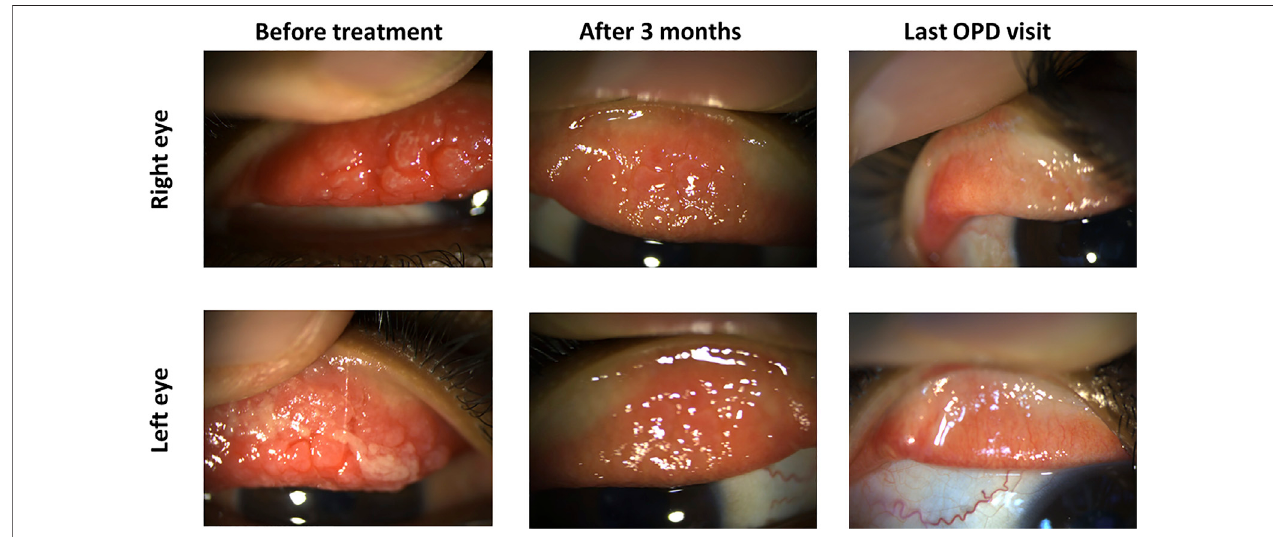
FIGURE 7 | Tacrolimus eye suspension for Case 3 of VKC. The left panel shows the upper eyelid of the right and left eyes in the fi rst visit before treatment with tacrolimus. Pictures from the fi nal OPD visit after 5 months are shown in the left panel.